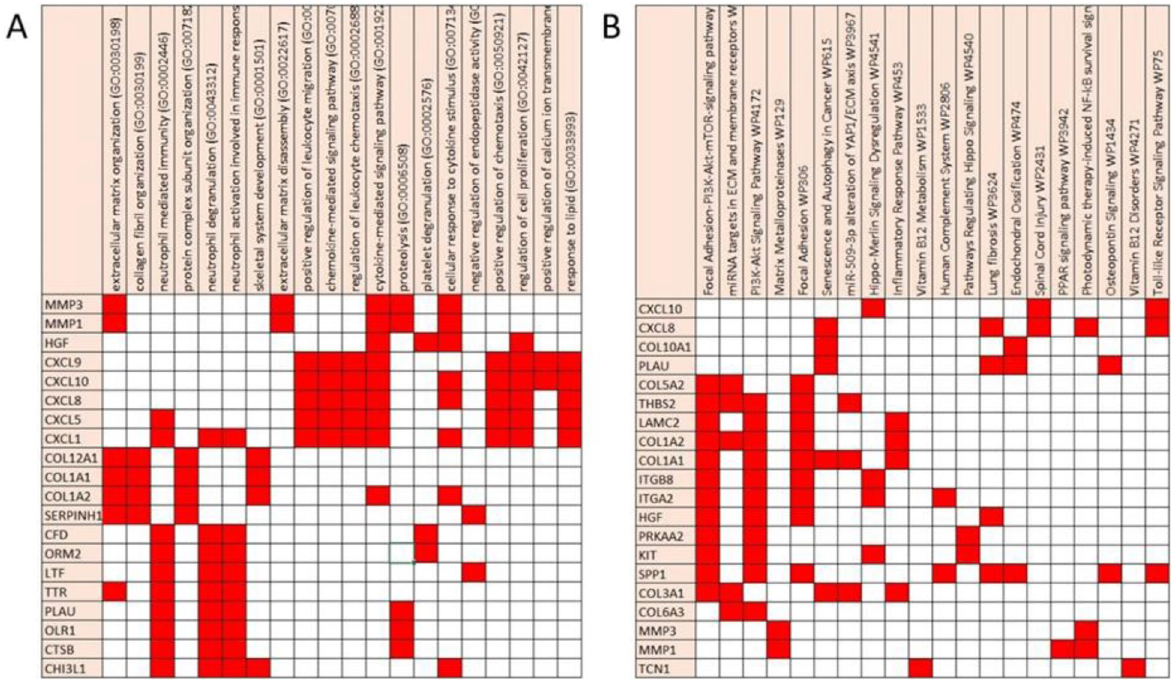
Fig. 4 Gene Set Enrichment Analysis for cluster 1 of the PPI network. Part A illustrates the enriched terms for biological process from GO repository. Part B shows the enriched pathways from WikiPathways signaling datasets. Red cells reveal the involvement of the genes in the enriched elements. Enriched terms were sorted based on the highest p